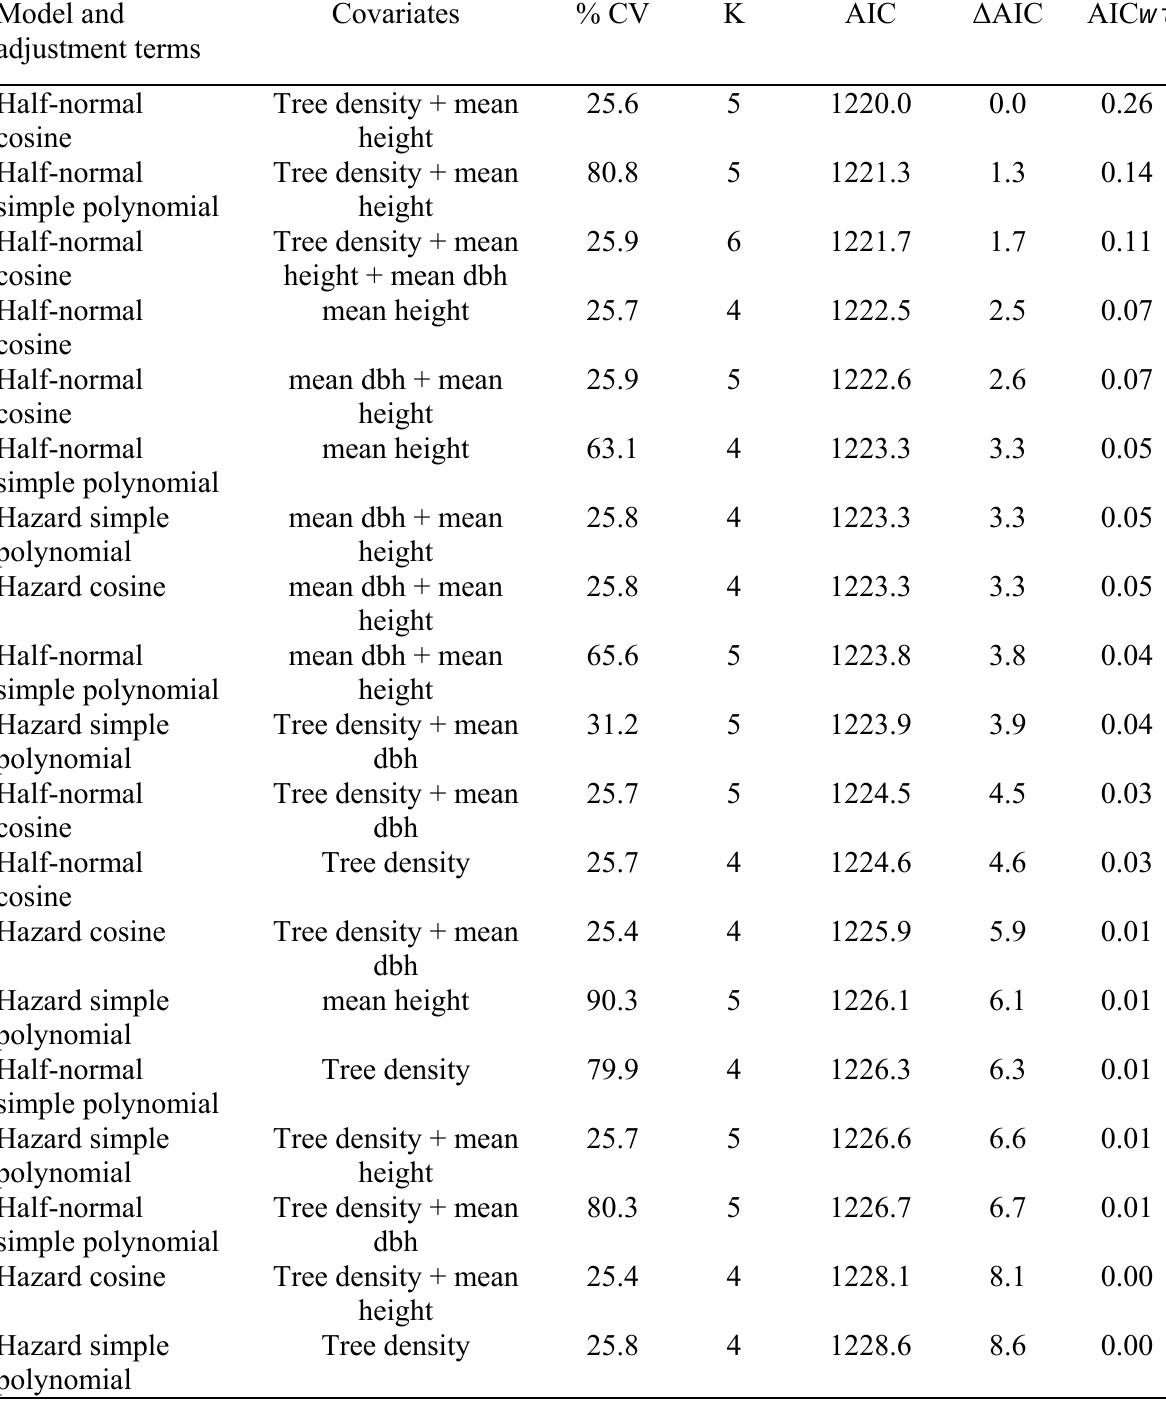
Table A1.2. Multiple-covariates distance sampling models with forest structure covariates for density of Northern Mealy Amazons during the breeding season (March 2014) in tropical moist forest of Los Chimalapas, Mexico. Models are ordered by the lowest Akaike’s Information Criterion (AIC), with delta Akaike differences (ΔAIC), and Akaike weights (AIC wi ) between models. K = number of parameters; % CV = Coefficient of Variation for each density